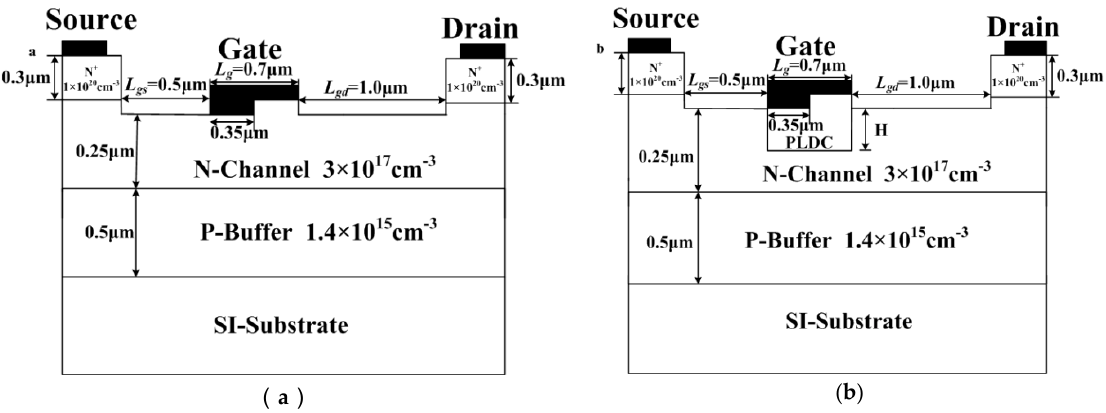
Figure 1. Schematic cross-sections of the ( a ) DR 4H-SiC MESFET, ( b ) partially low doped channel (PLDC) 4H-SiC MESFET.